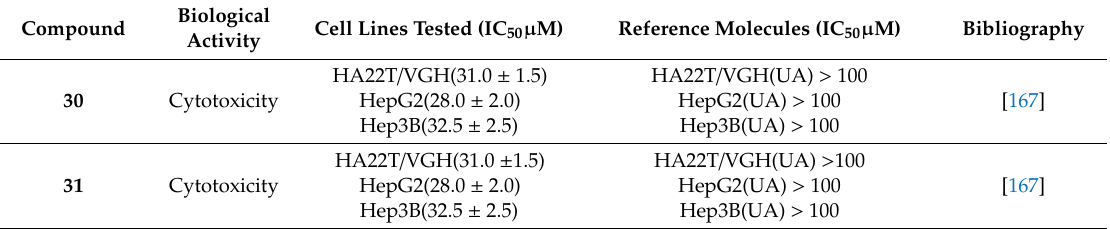
Figure 3. Fontana and Xu ‘s UA derivatives. Table 5. Modification of β-hydroxy (C-3).